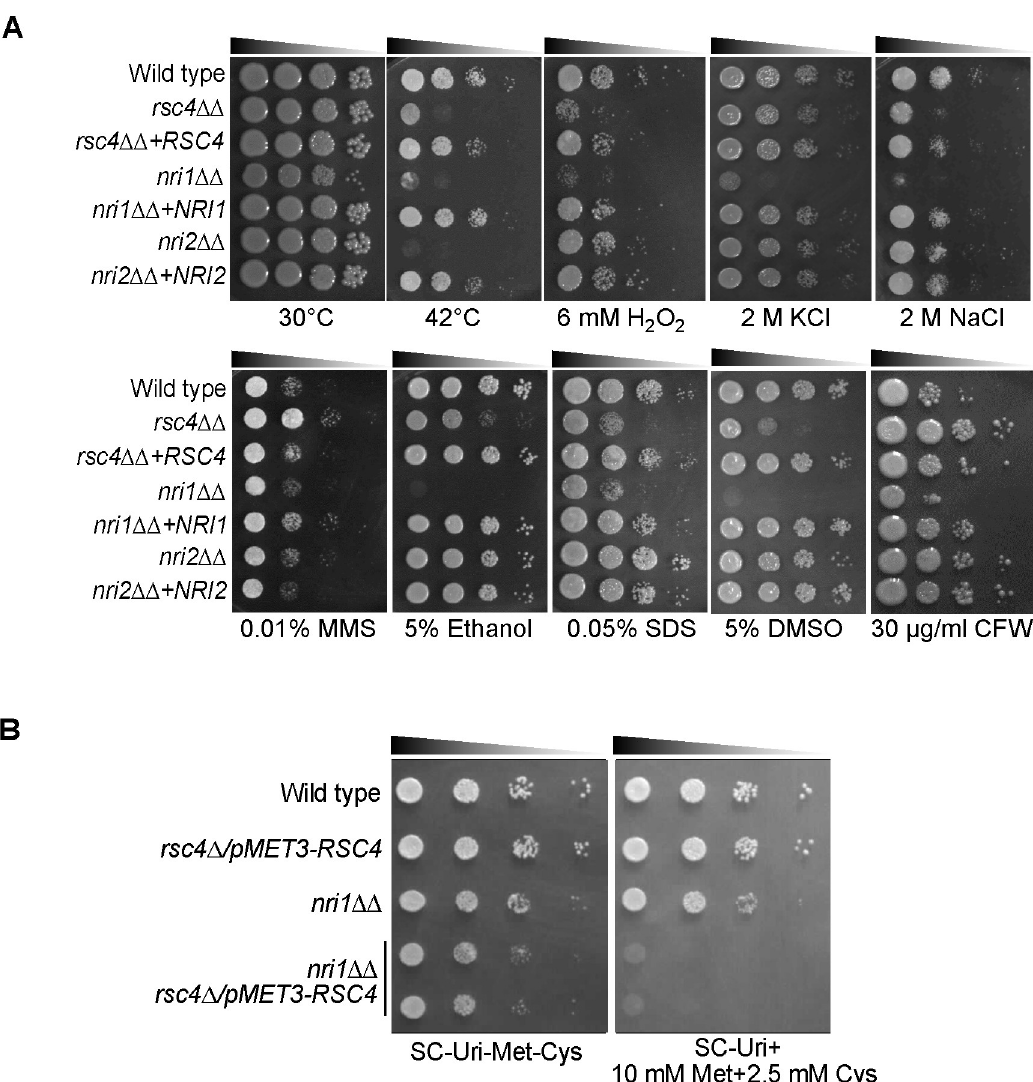
Fig 5. Functional links between RSC4 and NRI1 revealed through phenotypic analysis and genetic interaction. A. Growth phenotypes of rsc4 ΔΔ , nri1 ΔΔ and nri2 ΔΔ mutants along with the corresponding re-integrants and wild type (WT:SGC2024; rsc4 ΔΔ :SGC2022; rsc4 ΔΔ + RSC4 :SGC2023; nri1 ΔΔ :SGC2047; nri1 ΔΔ + NRI1 :SGC2049; nri2 ΔΔ :SGC2032; nri2 ΔΔ + NRI2 :SGC2036) under various in vitro stress conditions. Serial dilutions of cells were spotted on YPD plates with the indicated stressors and incubated at 30˚C, except where mentioned otherwise, and photographed after 2–3 days. B. Genetic interaction between RSC4 and NRI1 . Serial dilutions of the indicated strains (WT:SGC2006; MET3-RSC4 :SGC2053; nri1 ΔΔ :SGC2047; nri1 ΔΔ MET3-RSC4 : SGC2084) were spotted on growth permissive (SC-Uri-Met-Cys) and repressive (SC-Uri+10 mM Met+2.5 mM Cys) plates and incubated at 30˚C for 2 days before they were